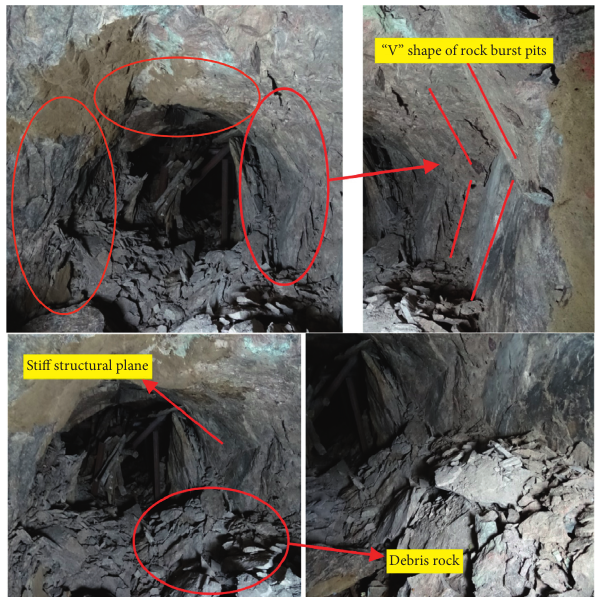
Figure 6: Rock burst in tunnel at a gold mine site